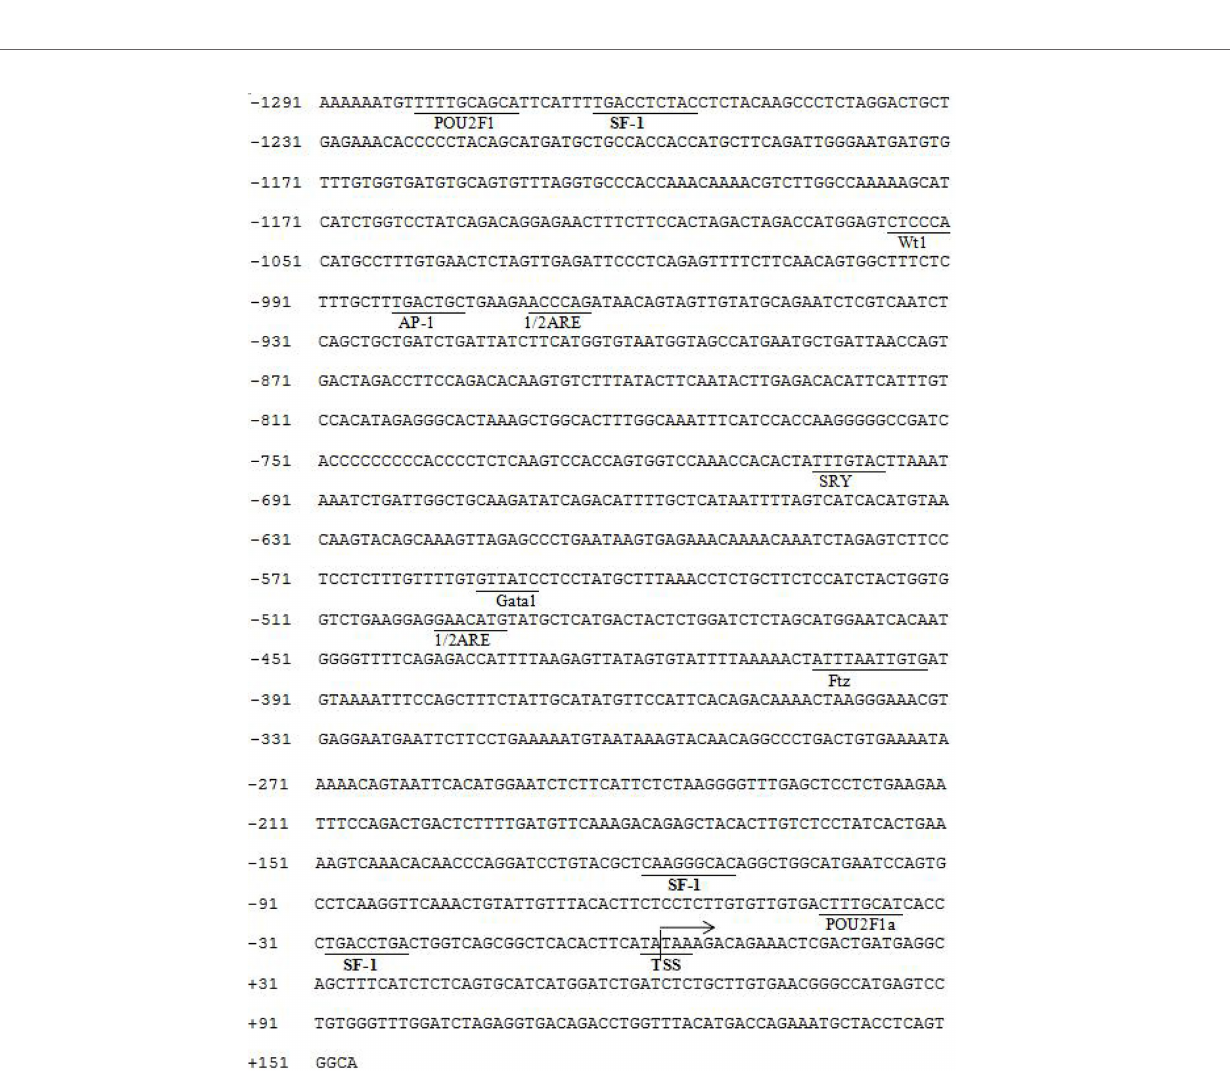
FIGURE 6 | Predicted binding sites of SF-1 on cyp19a1a promoter sequence. The underlined location is the binding site of the predicted transcription binding factor on the initiation. Numbers indicate the distance between the rightmost base in the row and the base of the transcription initiation codo. TSS: Initial site, arrow direction: transcriptional